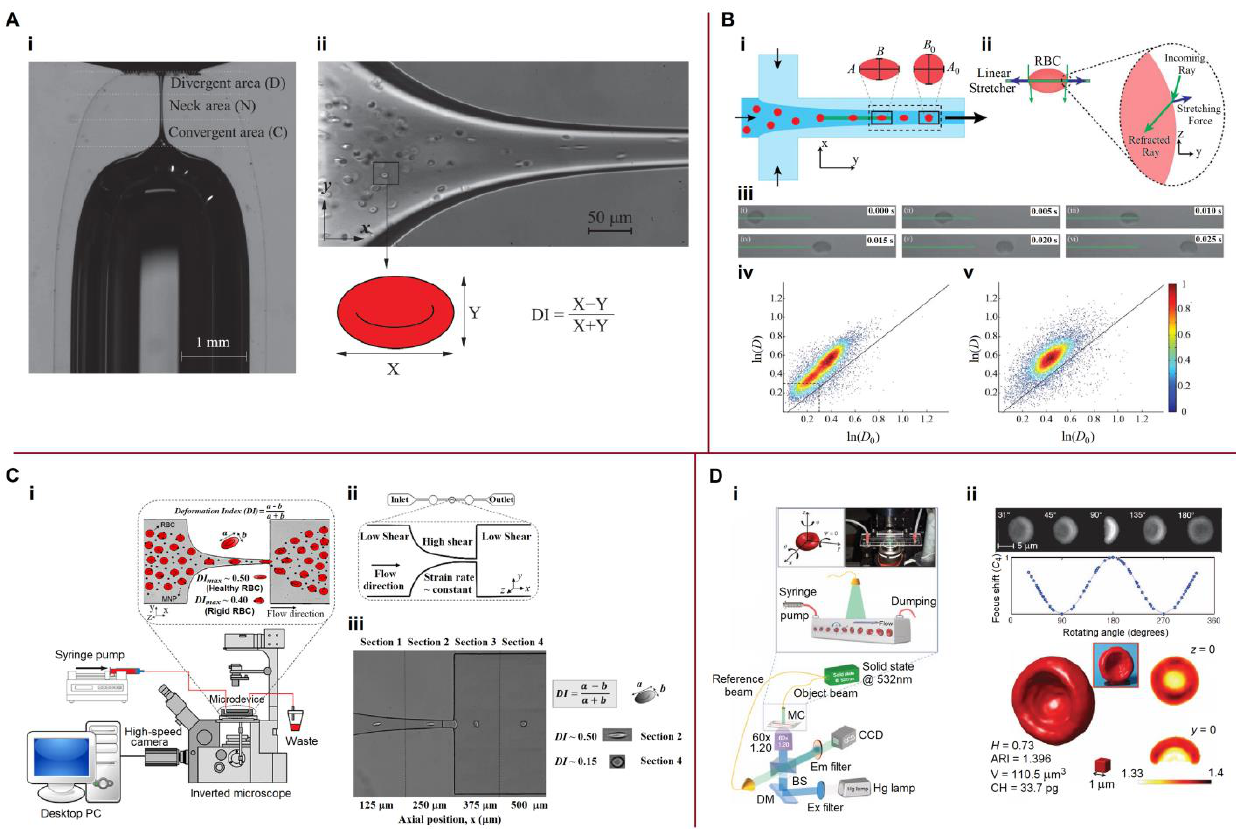
Figure 7. Systems for characterizing the deformability of biological cells. ( A ) Cell deformability in micronozzle: ( i ) Whole shape of a glass micronozzle with a 37 μ m neck diameter. ( ii ) Healthy RBCs flowing through a micronozzle. ( iii ) DI as a function of the section diameter for healthy (normal bars) and chemically treated (meshed bars) human RBCs. Reproduced with permission from [139]. Copyright 2019, IOP Publishing Ltd. ( B ) Linear optical stretcher: ( i ) Hydrodynamic focusing of cell and optical stretching. Cells observed in a rectangular region of interest (125 × 15 μm ). ( ii ) Optical stretching forces. Stretched aspect ratio is D = ( A / B ), and the relaxed aspect ratio is D 0 = ( A 0 / B 0 ). ( iii ) RBC stretch and relaxation cycle. The green bar shows the position of the linear optical stretcher. ( iv ) Cell aspect ratio for pure RBCs. ( v ) RBCs treated with 3.8 mM diamide. Reproduced with per- mission from [140]. Copyright 2015, International Society for Advancement of Cytometry. ( C ) Mi- crofluidic studies of the RBCs in contact with MNPs: ( i ) Schematic view of the experimental setup. ( ii ) Microchannel device geometry with the zoom of the hyperbolic channel. ( iii ) Image and DI of healthy RBCs flowing along the axial position of a microchannel with a hyperbolic-shaped contrac- tion followed by a sudden expansion. Reproduced with permission from [141]. Copyright 2016, Springer Science + Business Media Dordrecht. ( D ) Rolling tomographic phase microscopy (R-TPM): ( i ) Working principles. ( ii ) R-TPM results. One-side concavity of RBC. Reproduced with permission from [142]. Copyright 2017, the author(s). Label-free tomographic phase microscopy (TPM) was used by Merola et al. [142] for high-throughput single-cell analysis (Figure 7D). The use of a complete angular revolution of cells in the microscope’s field of view and the application of the tomographic reconstruc- tion algorithm allowed the complete characterization of cells in terms of several metrics, including 3D morphology, corpuscular hemoglobin (CH), volume (V), and average refrac- tive index (ARI) (Figure 7D(ii)). This approach was named rolling-TPM (R-TPM). Besedina et al. [143] fabricated a microfluidic device that simulated a capillary network to characterize erythrocyte circulation under oxidative stress. Data for the analysis of erythrocyte transport in the microchannels were recorded using a high-speed camera and microscope. The rec-